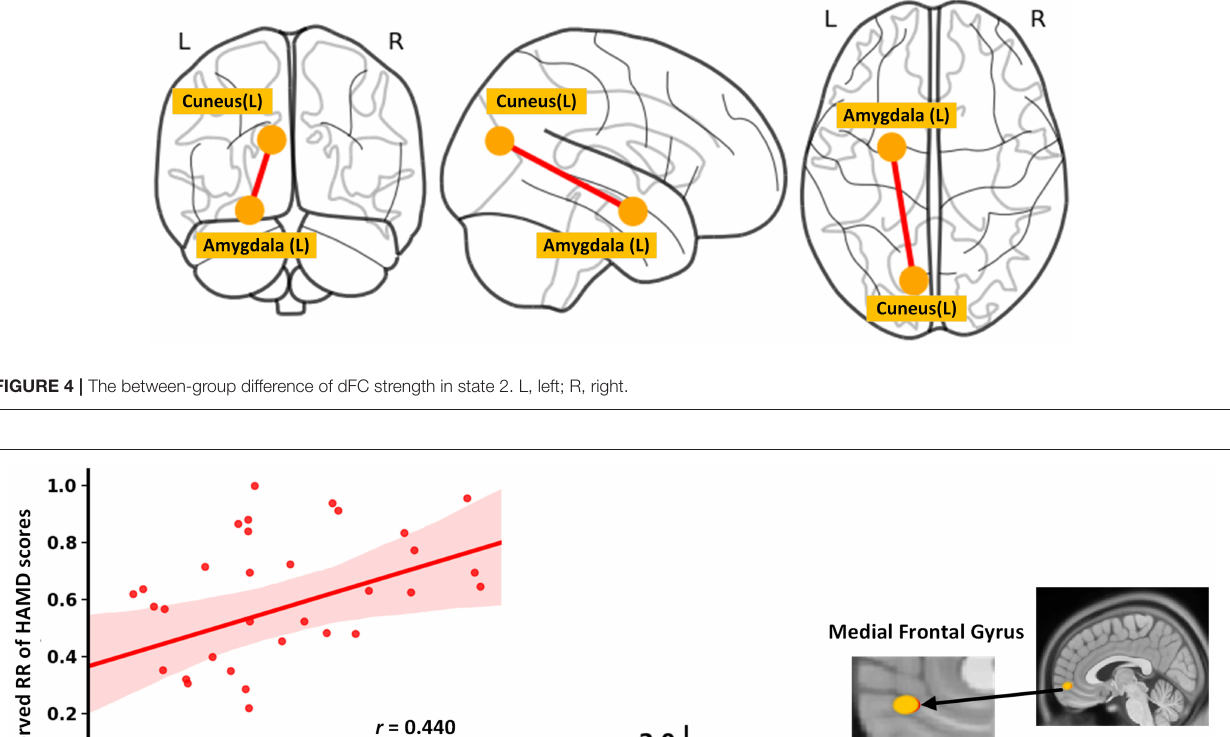
demonstrate that the dynamic interactions among LBNs serving for emotion regulation have the potential to be the target of clinical intervention for